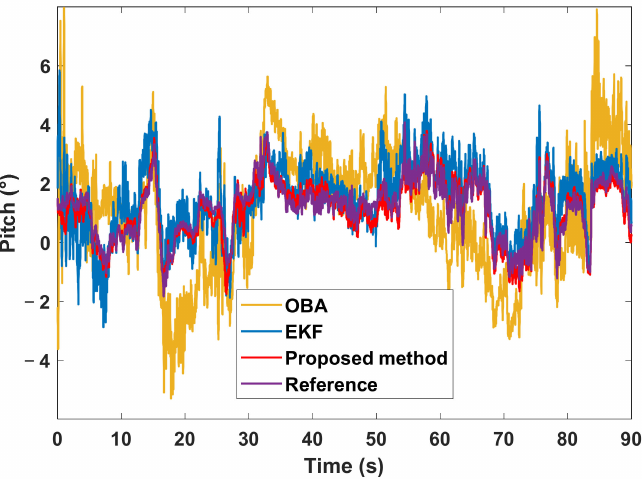
Figure 13. Real time pitch angle estimation curves of three different IFA